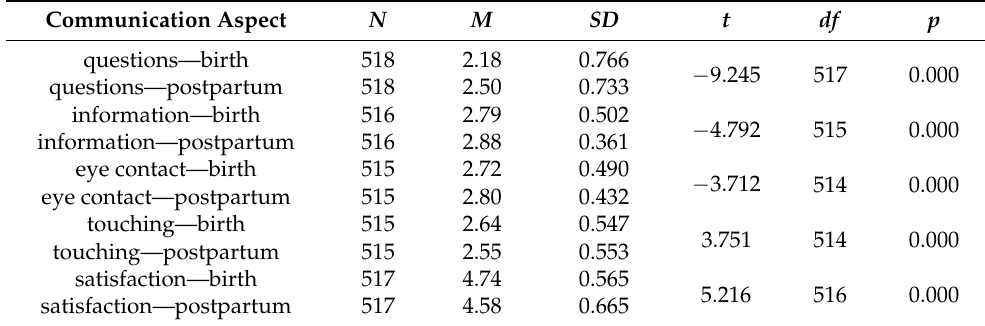
Table 1. Descriptive statistics and results of the dependent t -test analysis of communication needs and communication satisfaction during childbirth and early postpartum.